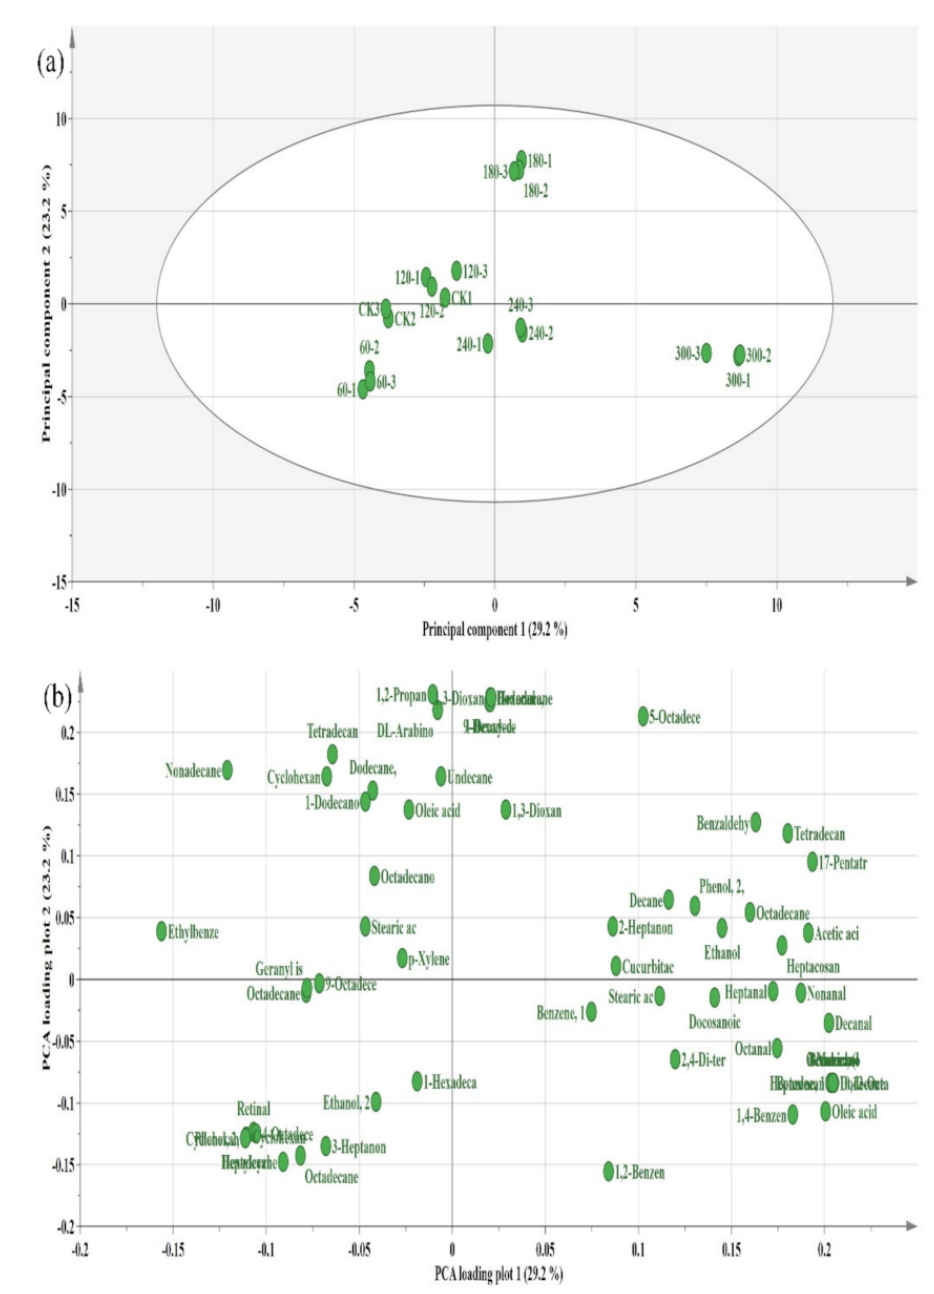
Figure 6. ( a ) PCA plot describing the variation in the volatile compounds’ fingerprints of HVCP- treated EWP; ( b ) Loading plot describing the distribution of volatile compounds’ fingerprints across various HVCP treatment on the EWP. PCA: Principal component